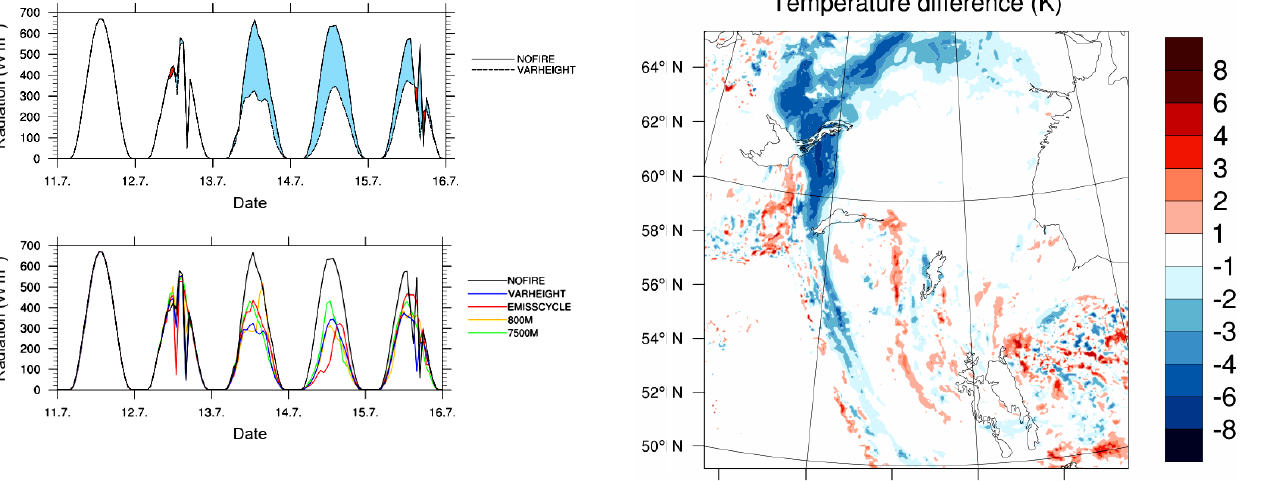
Figure 12. Surface short-wave radiation in Fort Smith for 5 days starting on 11 July 2010, for the simulation without fire emissions and a simulation with fire emissions (top), and the same for the simulations with different parametrizations for plume height and vertical distribution of the emissions (bottom).